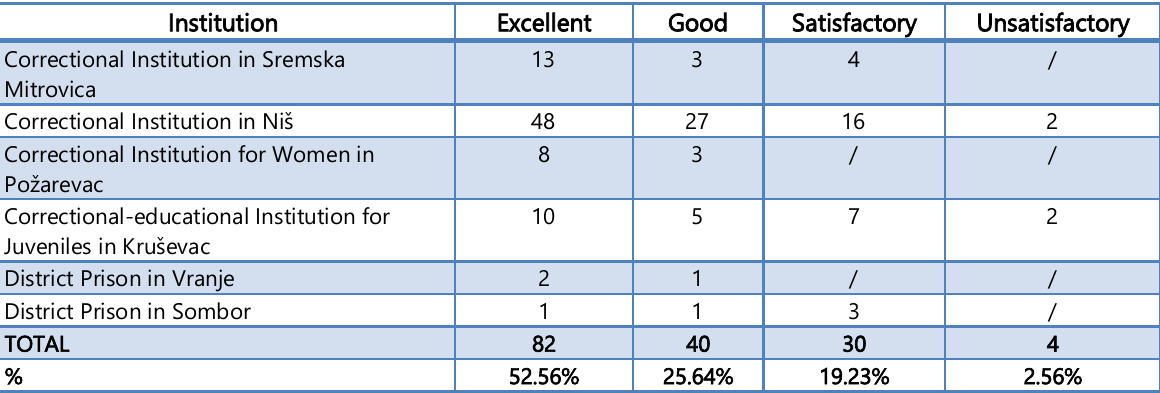
Table 8: How the Interviewed Persons Evaluate the Program in Which They Participated – Inmates (Source: Author‟s depiction)